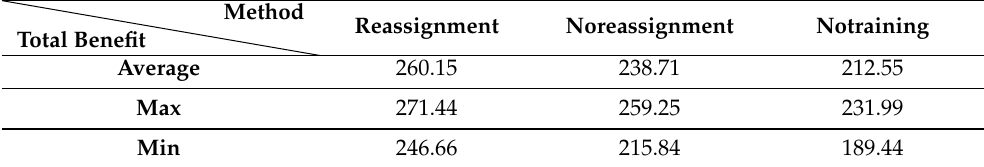
Table 4. The result